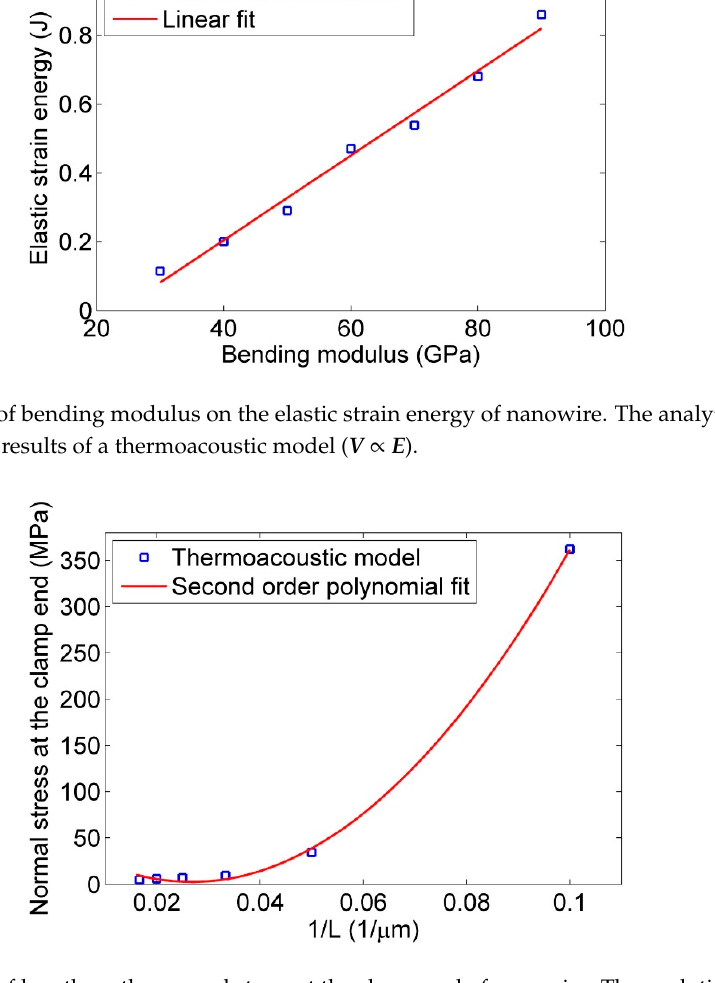
(cid:2778) (cid:2778) ). ). (cid:2778) (cid:2168) (cid:2779) ). (cid:2168) (cid:2779) (cid:2168) (cid:2779) L 2